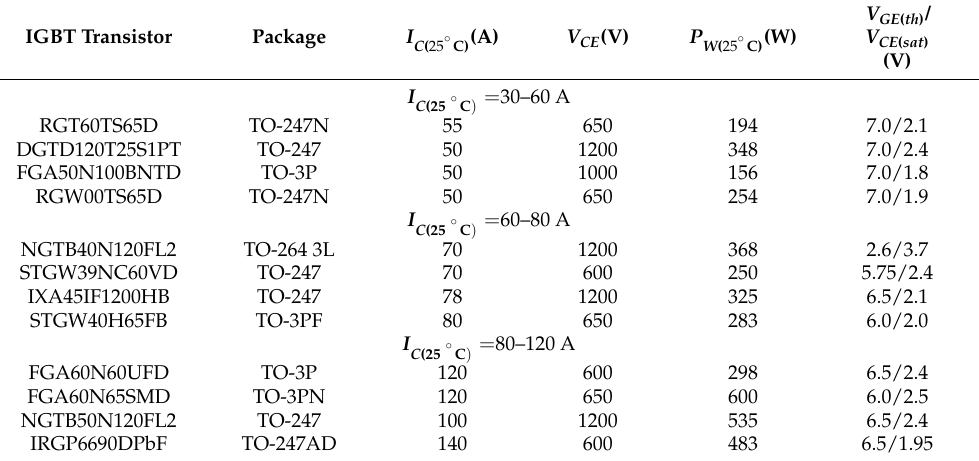
Table A1. IGBT transistors, suitable for experimental verification with resonant inverters for induc- tion heating, operating with